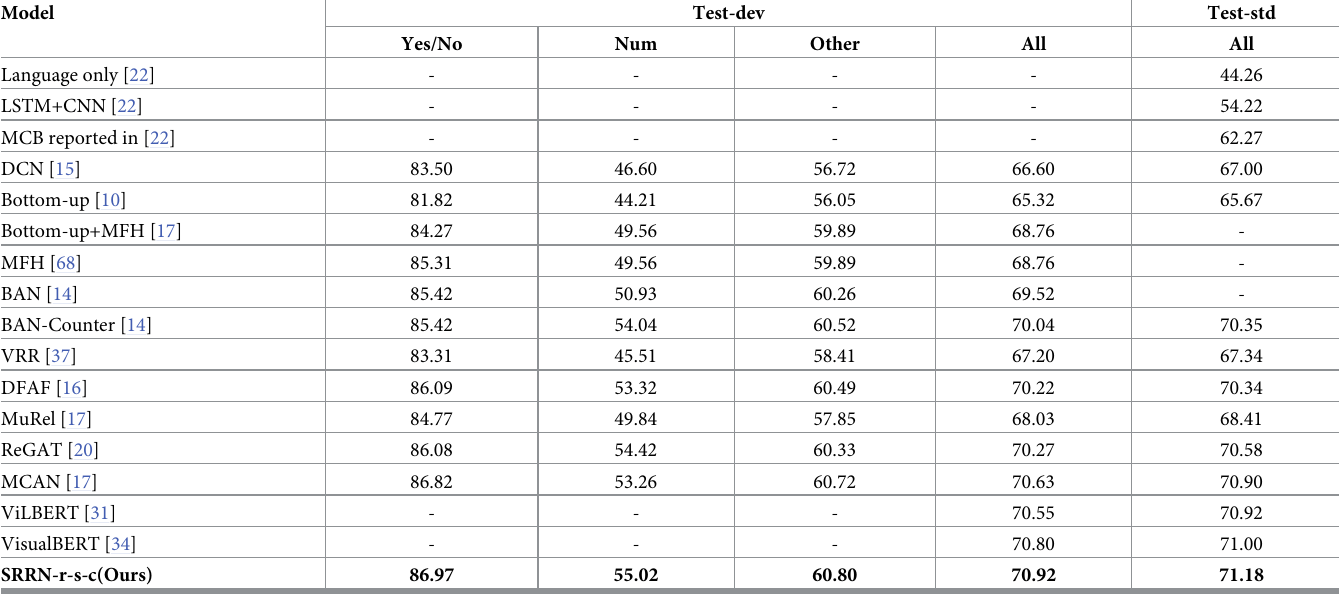
Table 4. Performance comparison results on VQA 2.0 dataset.